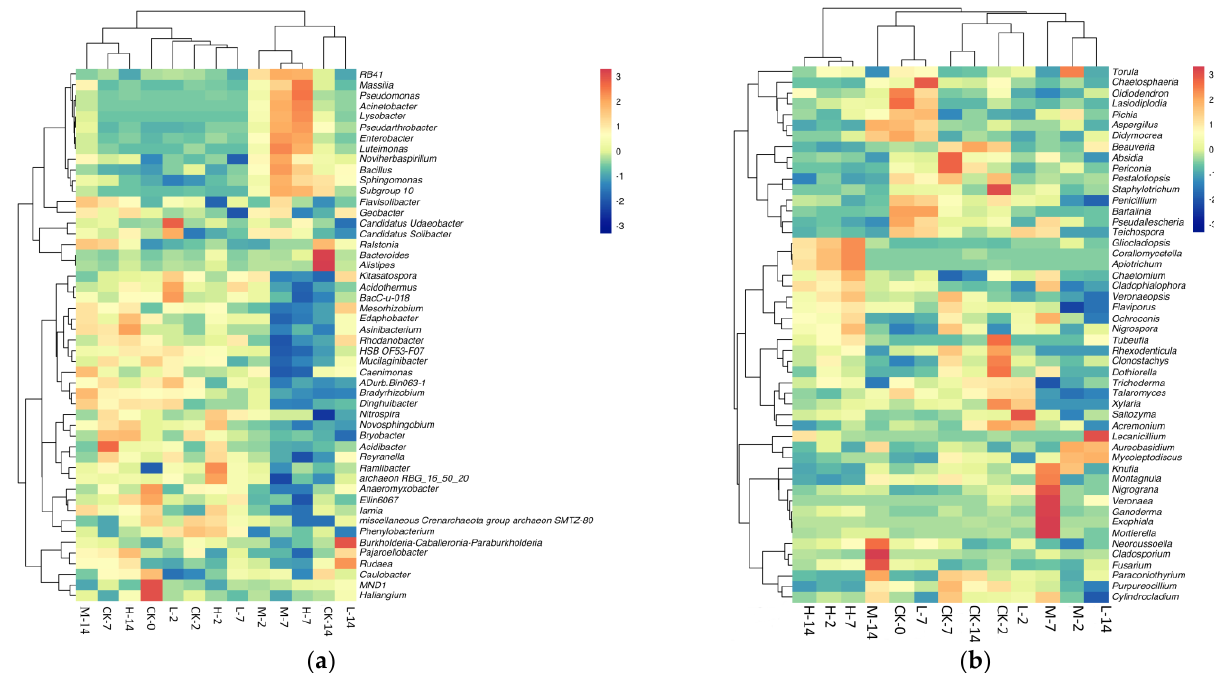
Figure 8. Heatmap of high − abundance bacteria ( a ) and fungi ( b ) at the genus level.